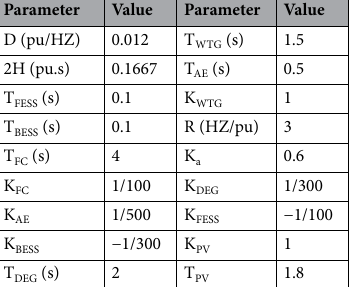
Table 1. The values of the parameters used in the microgrid frequency